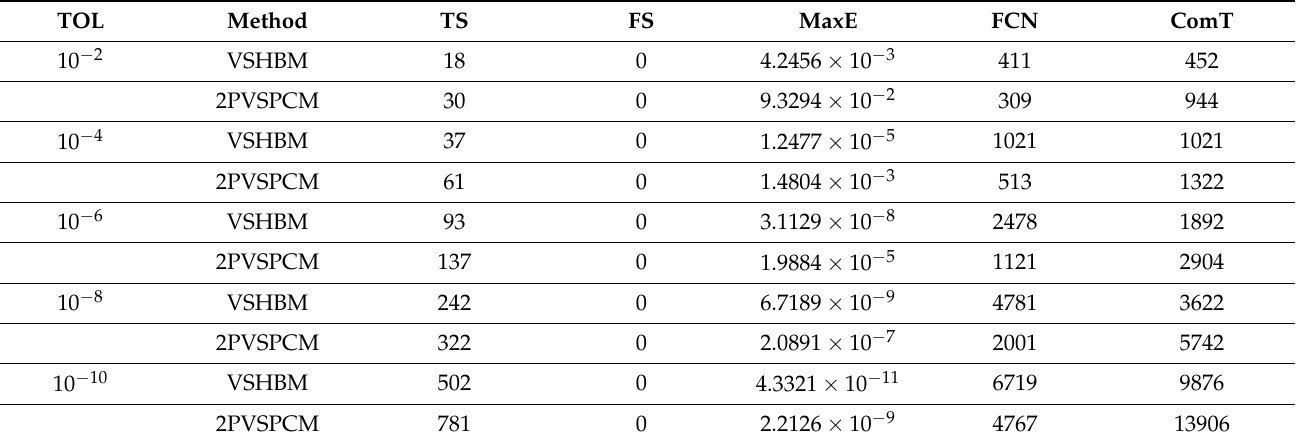
Table 4. Performance of the VSHBM on Kepler problem with eccentricity 1 − e = 0.0000001 and run time t (cid:101) [ 0,20 ] .